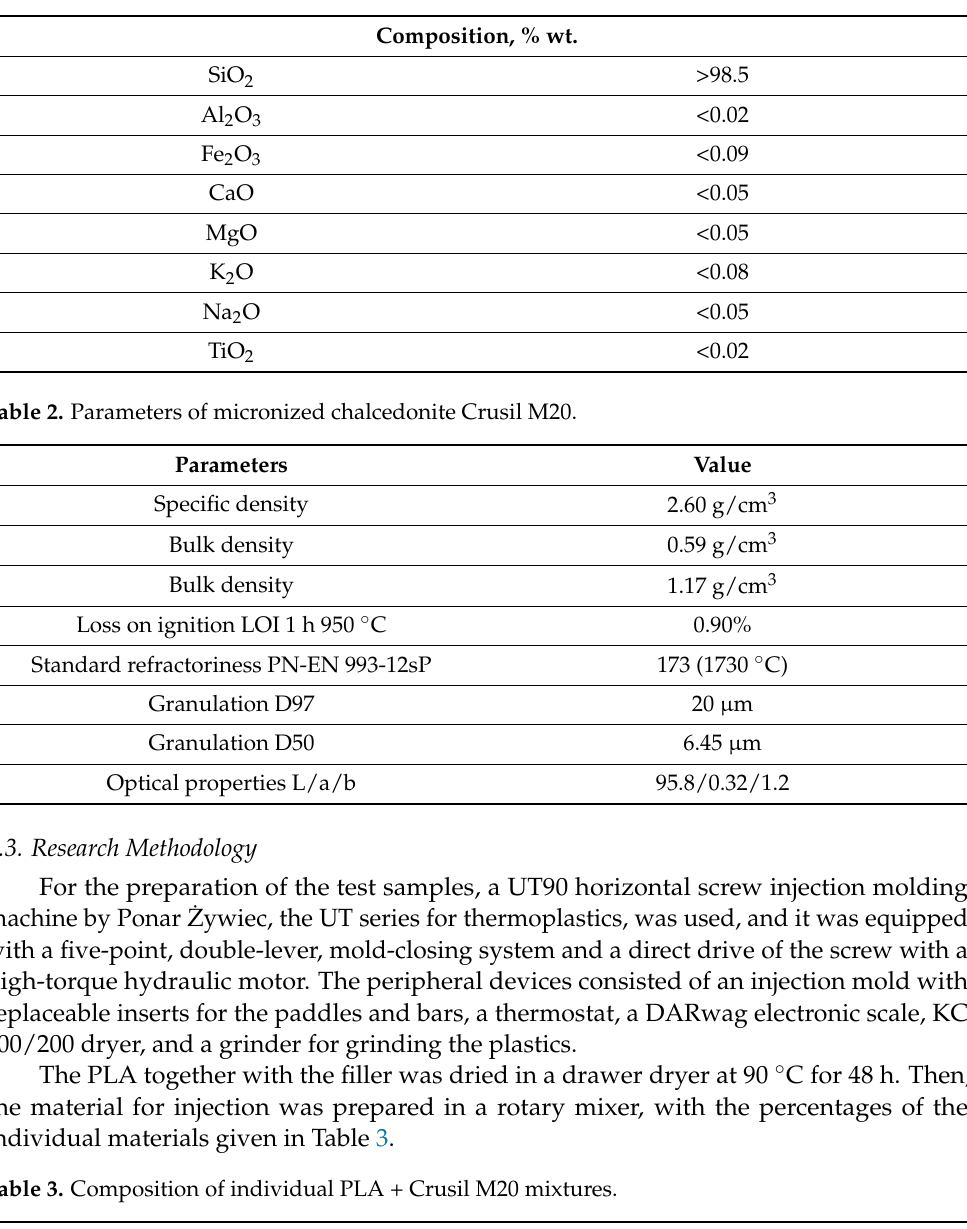
Table 1. Chemical parameters of micronized chalcedonite Crusil M20.